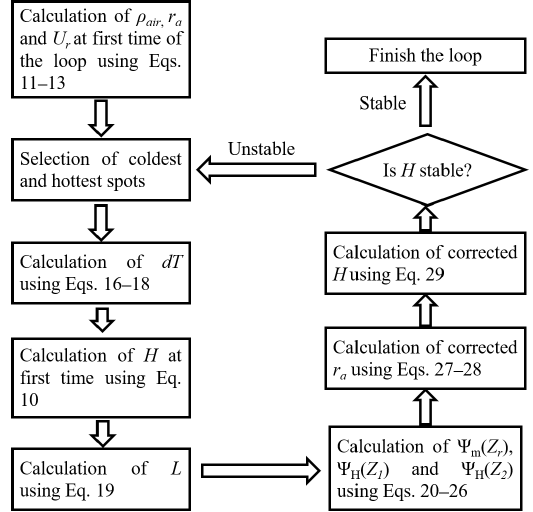
Figure A1. A flowchart of the calculation of sensible heat flux using Monin–Obukhov similarity theory